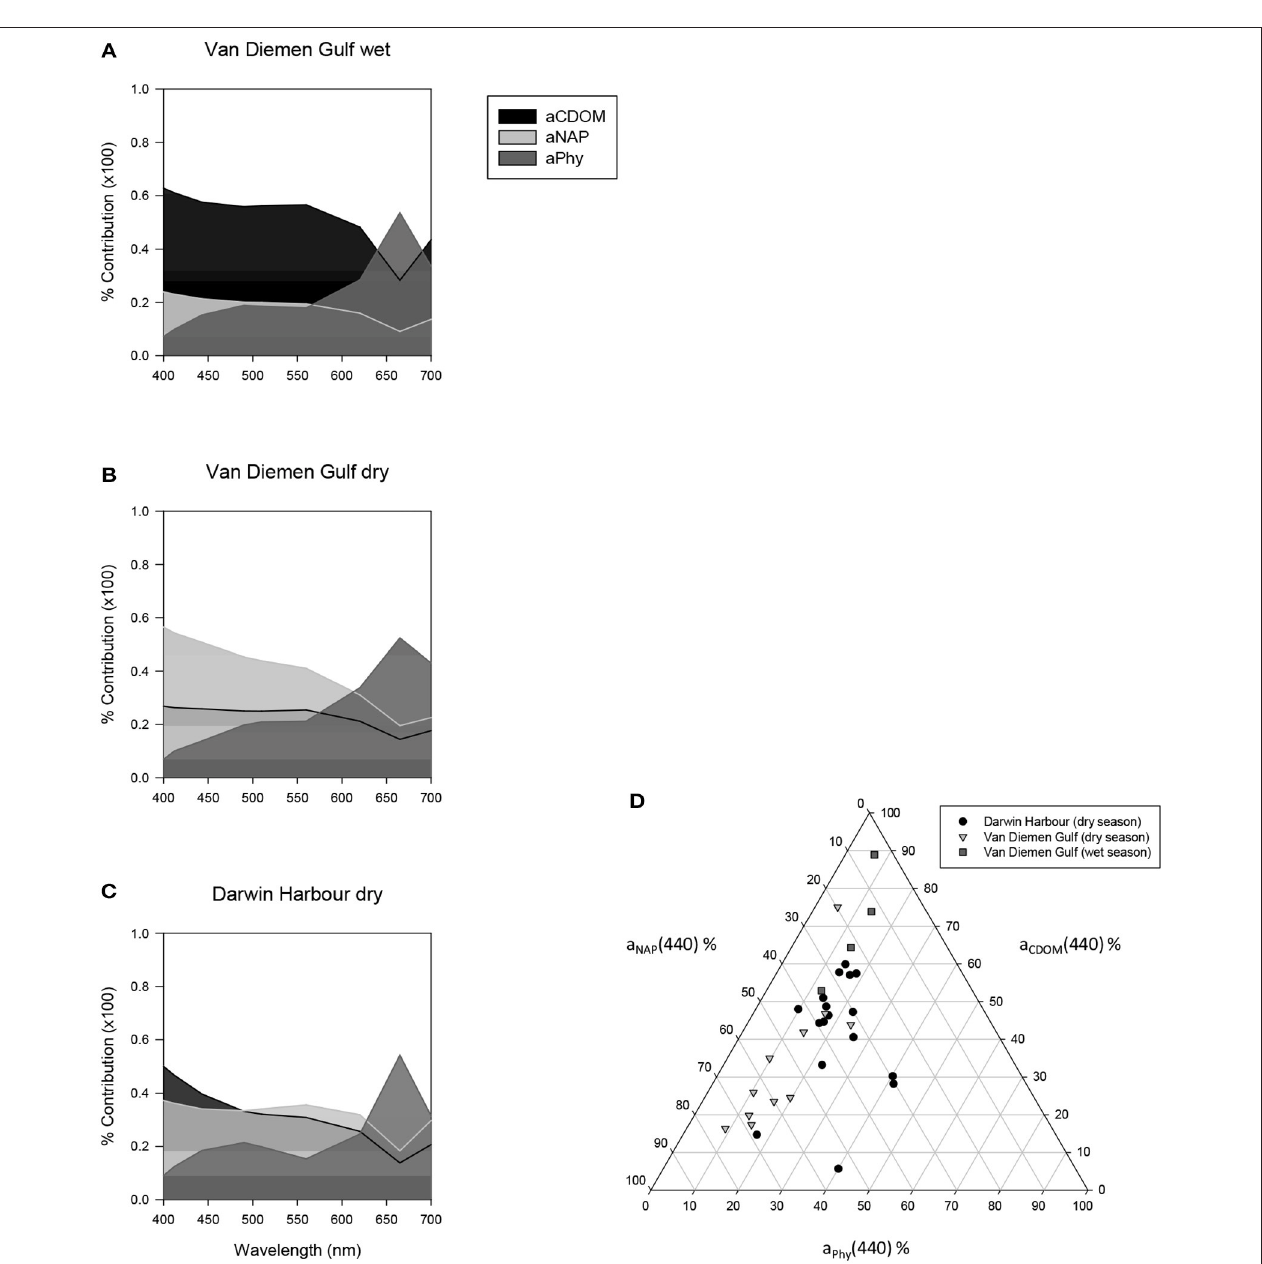
FIGURE 8 | Average relative contribution of CDOM, NAP, and phytoplankton to the total absorption between 400 and 700 nm (A–C). Wavelength-specific ternary plot of their relative absorption at 440nm (D)